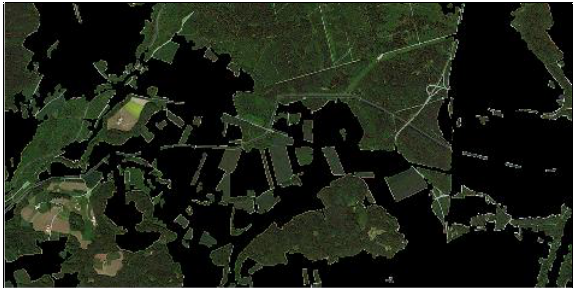
Figure 8. ROI detection (Forest) by the proposed